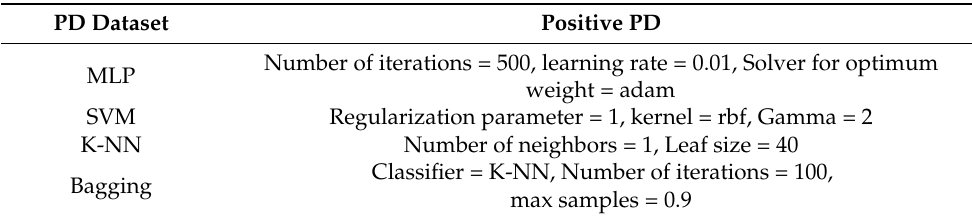
Table 4. Hyperparameter settings of each ML classifier. PD